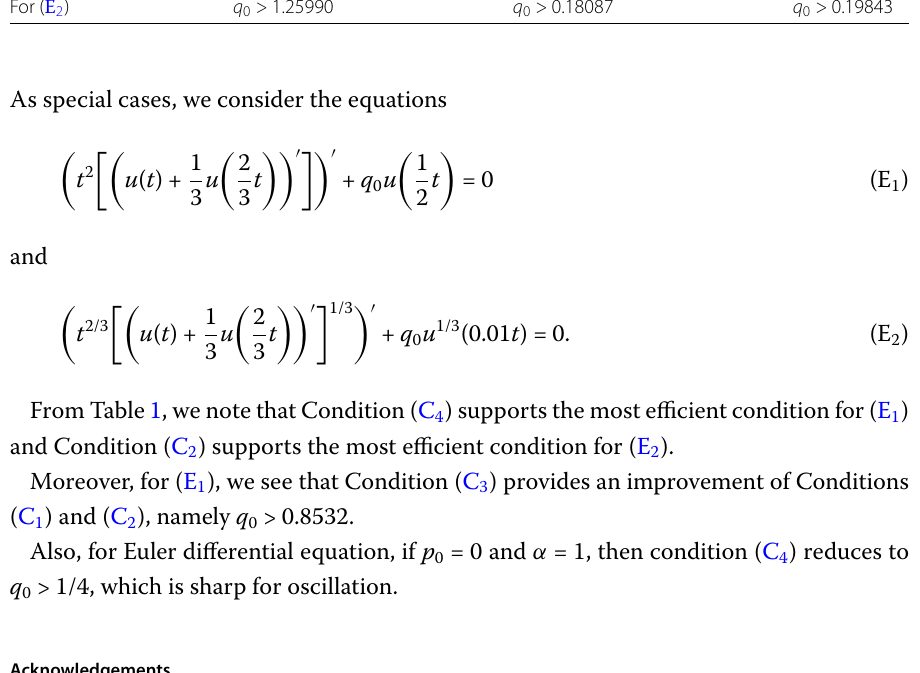
Table 1 Test of the strength of criteria for ( E 1 ) and ( E 2 ) Condition ( C 1 ) Condition ( C 2 ) Condition ( C 4 ) For ( E 1 ) q 0 > 2.00000 q 0 > 1.06150 q 0 > 0.50000 For ( E 2 ) q 0 > 1.25990 q 0 > 0.18087 q 0 >